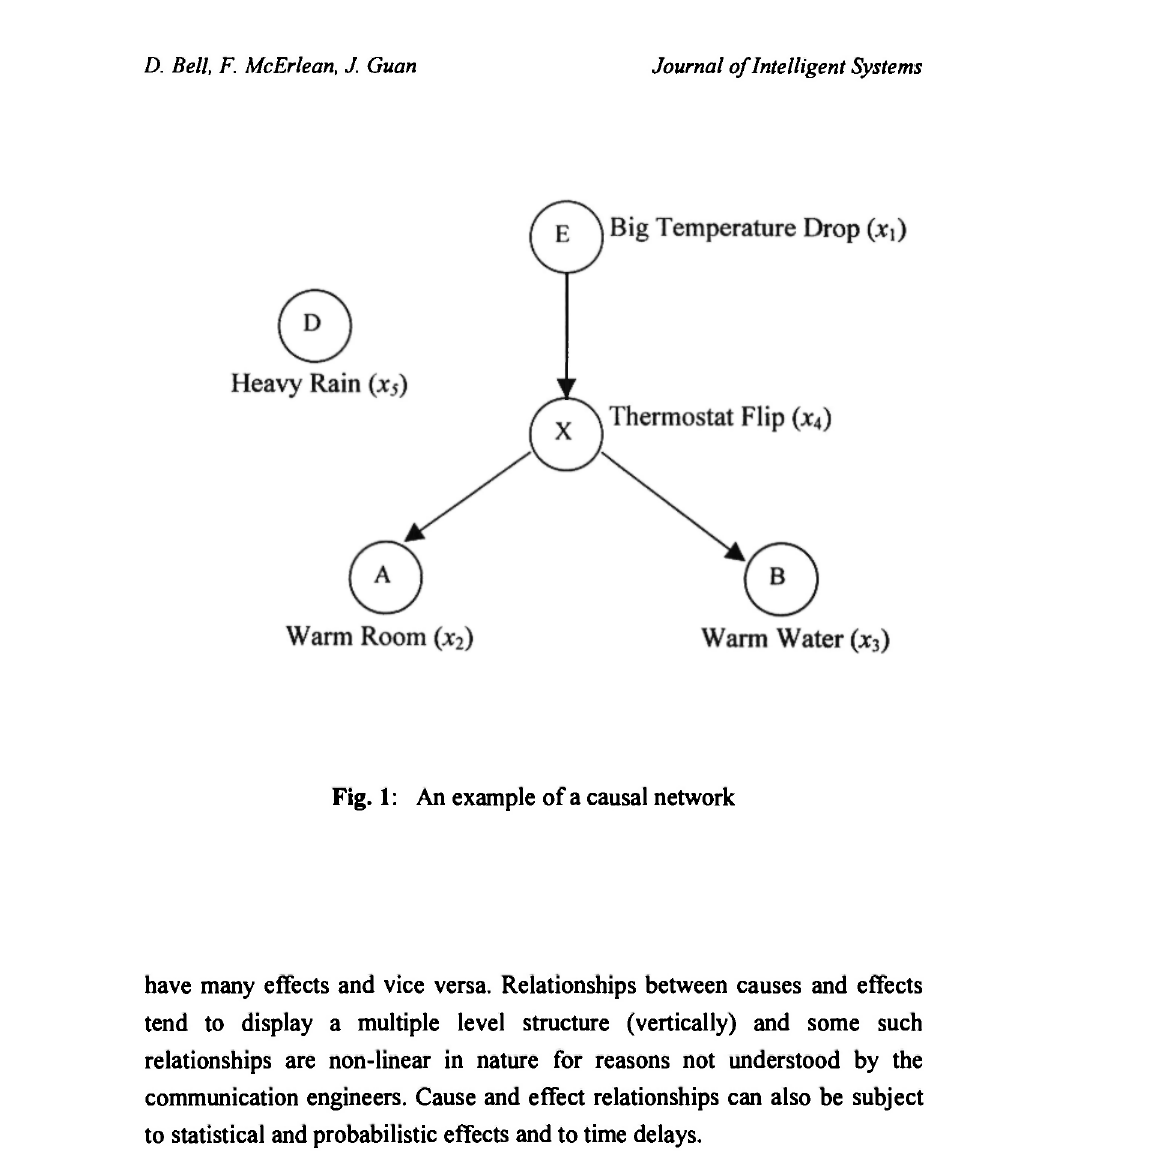
Fig. 1: An example of a causal